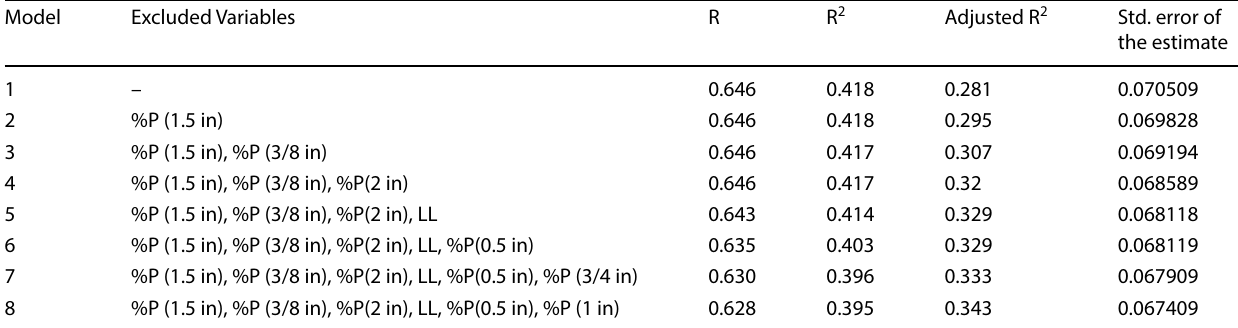
Table 7 Steps of the backward elimination process for developing the MDD MLR model